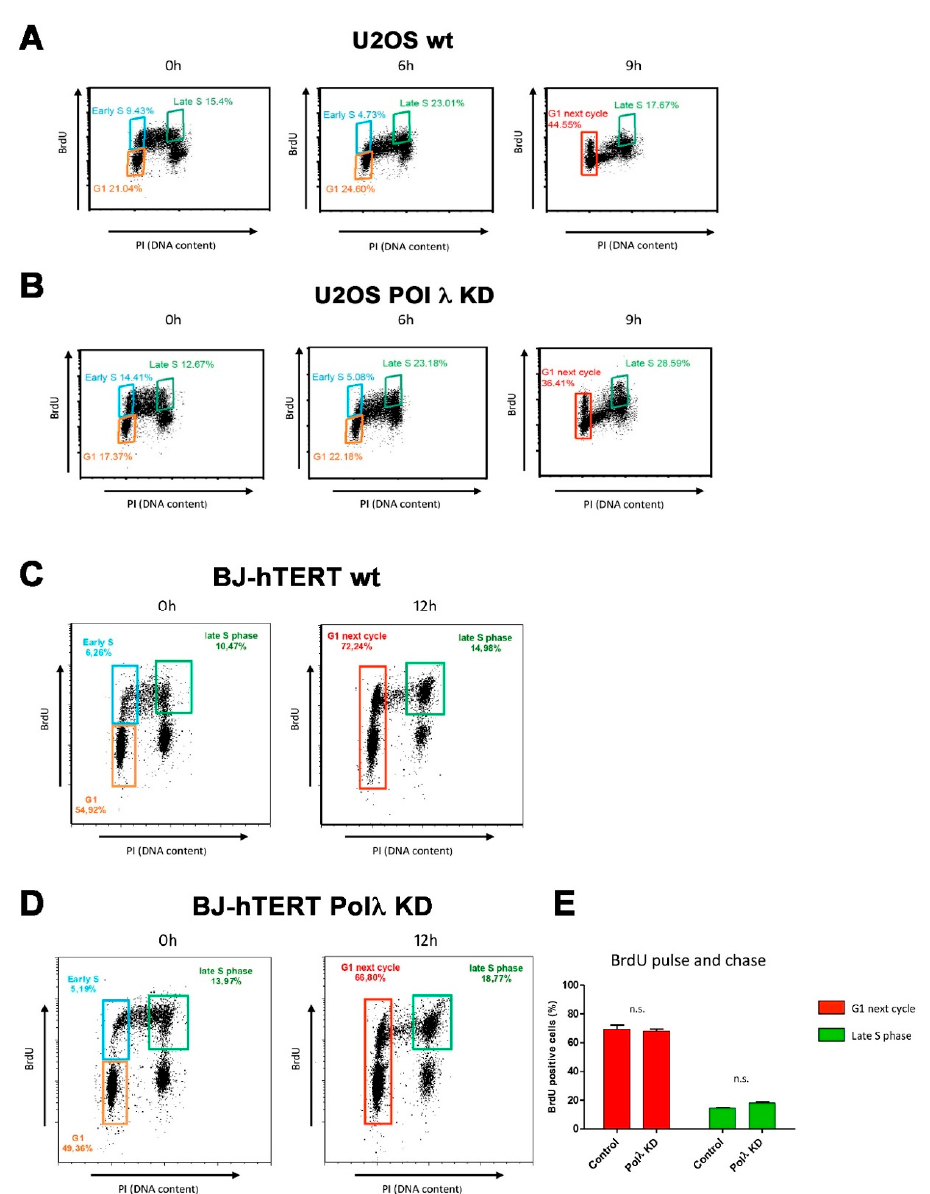
Figure 3. Pol λ silencing causes a slower progression through late S-G2 phases in ALT cells. The cell cycle progression was monitored by FACS. The orange gate indicates the percentage of cells in the G1-phase. The blue gate indicates the percentage of cells in early S-phase and the green gate indicates the late S-phase. The red gate at the 9 h time point indicates the early S-phase + G1-phase of the next cycle. ( A ) U2OS cells transfected with scrambled siRNA were pulsed with BrdU for 30 min and the DNA replication was followed after its withdrawal for 0–6–9 h in cells. The cells were stained with an anti-BrdU specific antibody and counterstained with propidium iodide (PI). ( B ) As in panel A but with U2OS cells silenced for Pol λ with the specific siRNA si98. ( C ) BJ-hTERT cells transfected with scrambled siRNA were pulsed with BrdU for 1 h and the DNA replication was followed after its withdrawal for 12 h in cells. The cells were stained with an anti-BrdU specific antibody and counterstained with propidium iodide (PI). ( D ) As in panel C but with BJ-hTERT cells silenced for Pol λ with the specific siRNA si98. ( E ) Quantification of cells in late S (green bars) or next G1 (red bars) for BJ-hTERT cells transfected with scrambled siRNA (Control) or silenced for Pol λ with the specific siRNA si98 (Pol λ KD). Values are the mean of three independent measurements. Error bars represent S.D. n.s., not statistically significant (Student’s t -test). The ability of Pol λ to perform MMST synthesis of telomeric DNA was then tested with two model substrates, which may be relevant for ALT. First, a 16/48 primer-template (Figure 4A top left scheme) was used, with a dideoxy-terminated primer end, so that